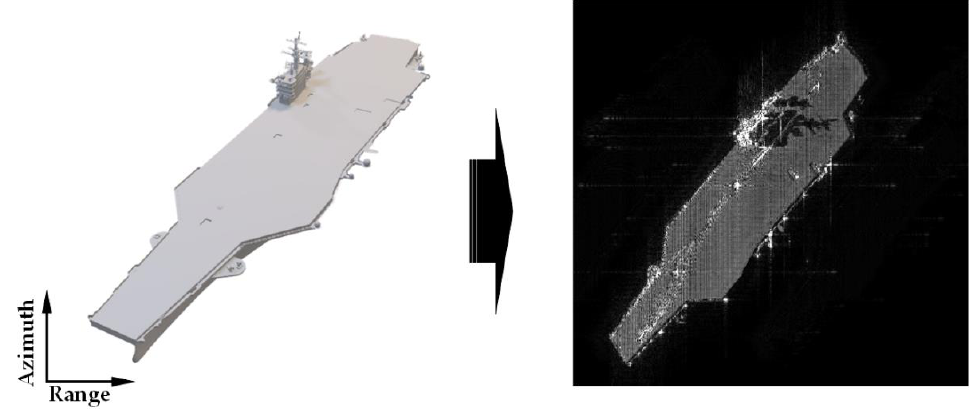
Figure 19. SAR Simulated image of aircraft carrier include multiple scattering.